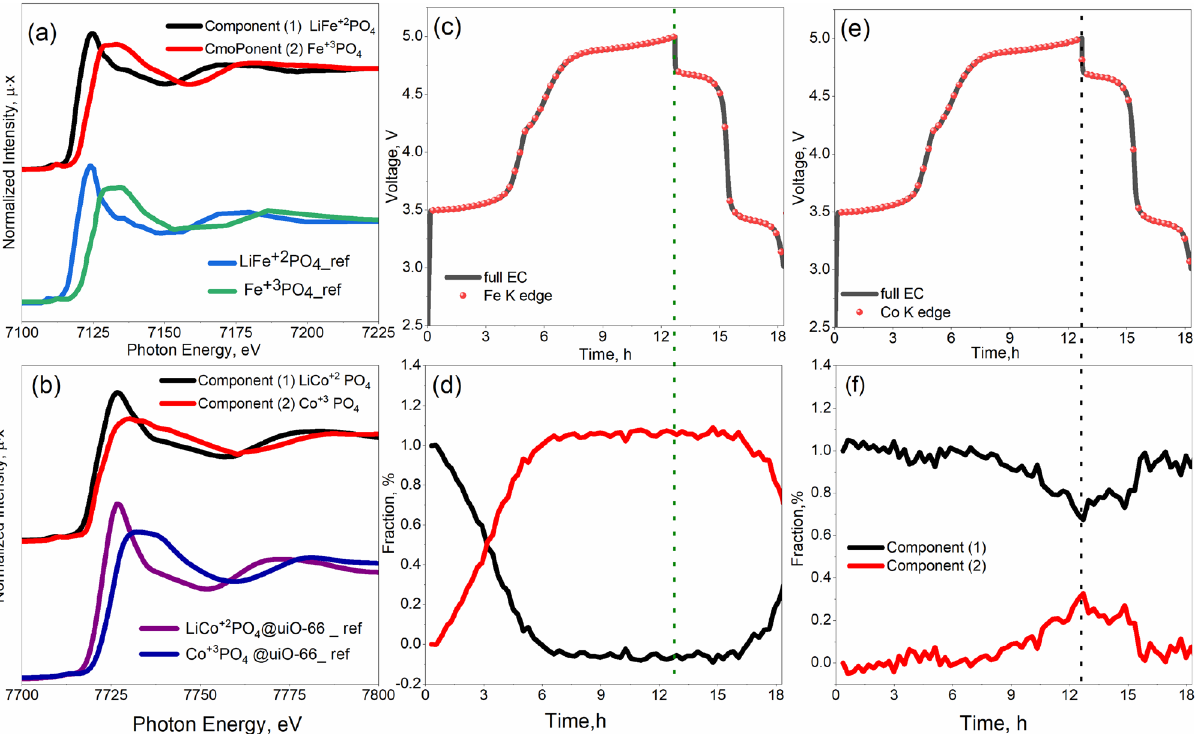
Figure 6. PCA components extracted from the series of operando XANES spectra for the Fe compared to the experimental spectra for LiFePO 4 and FePO 4 (ref. 40 ) ( a ) and Co ( b ) K-edge in the LiCo 0.5 Fe 0.5 PO 4 cathode material, compared to the experimental spectra of the reference compounds (LiCoPO 4 @UiO-66) 7 . ( c ) Cell voltage of Fe during the first cycle dots on a black voltage profile mark the start time for measuring each successive XAS spectrum. ( d ) PCA phase concentration of the Fe 2+ and Fe 3+ components compared to the cell potential. ( e ) Cell Voltage of Co during the first cycle dots on a black voltage profile marks the start time for measuring each successive XAS spectrum. ( f ) PCA phase concentration of the Co 2+ and Co 3+ components compared to the cell